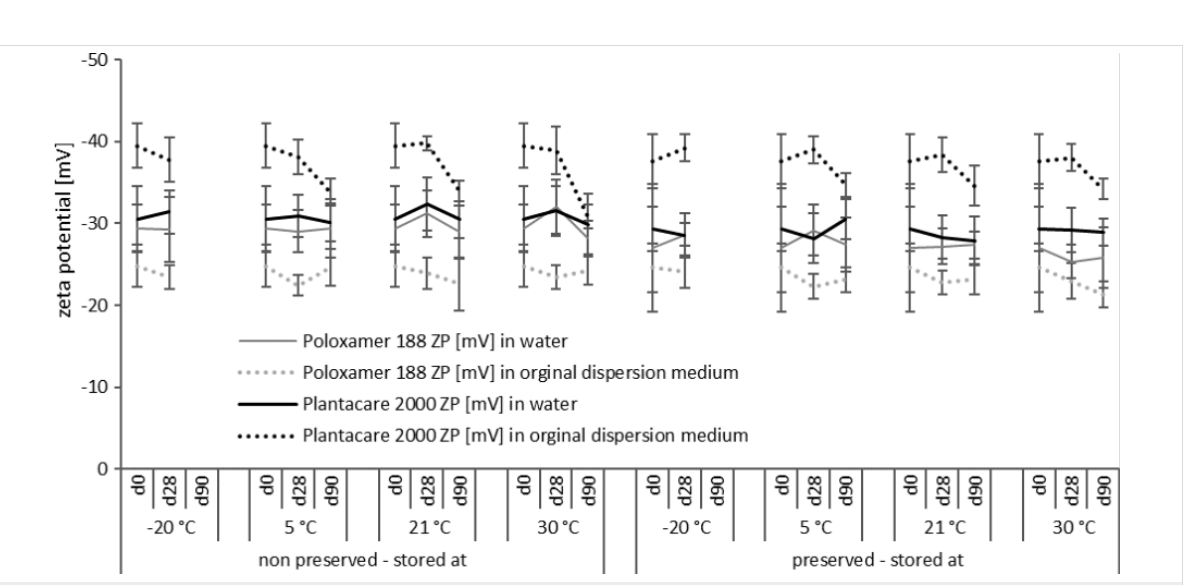
Figure 8: Determination of zeta potentials of the non-preserved and preserved rutin nanosuspensions during three months of storage at different storage